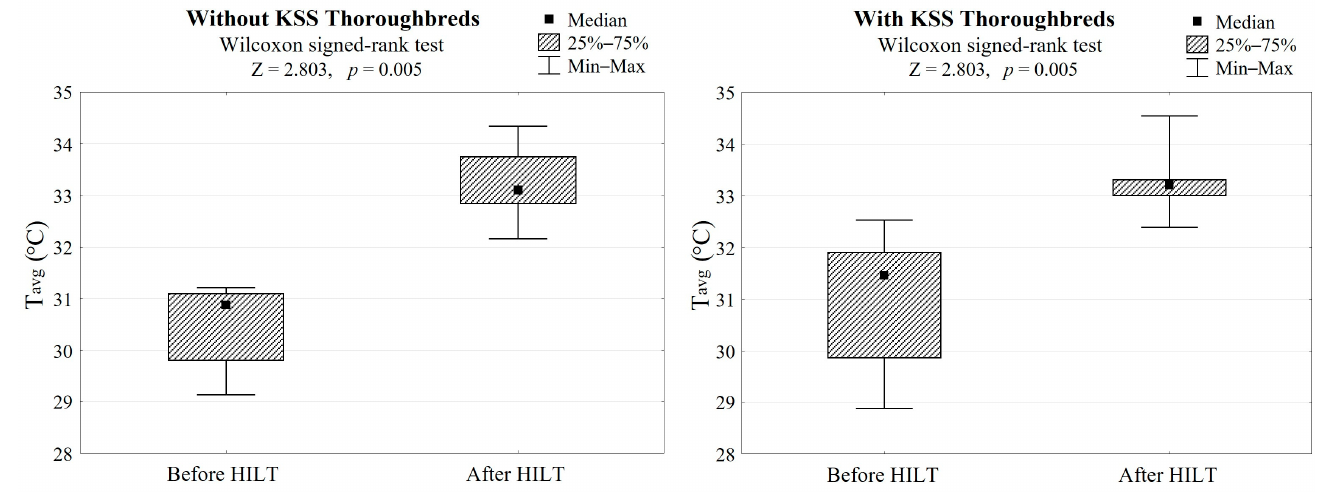
Figure 2. Differences in skin surface temperatures after HILT application in both groups (with/without KSS) and the Wilcoxon signed-rank test results. T avg refers to the average skin surface temperature after HILT. There was no correlation between changes in the average skin surface temperature and average palpation scores in either group (rho = 0.071 for group without KSS and r = − 0.180 for with KSS, p > 0.05; Table